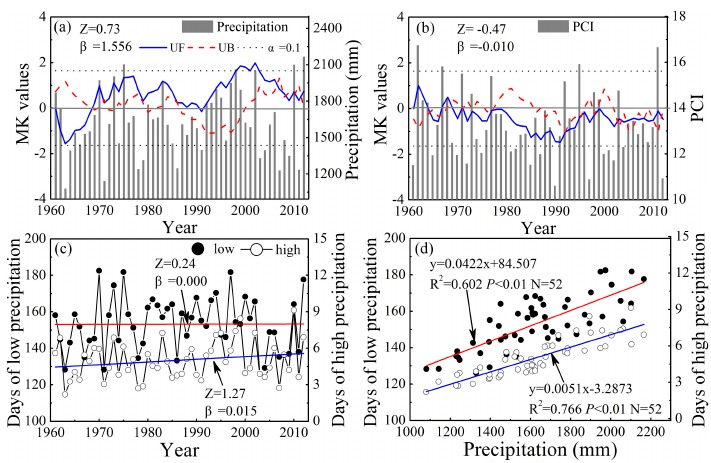
Figure 5. Area ‐ average precipitation ( a ); area ‐ average PCI ( b ); and the rainy and rainstorm day ( c ); and their correlation with precipitation ( d ) for the entire Poyang Lake Basin from 1961 to 2012.